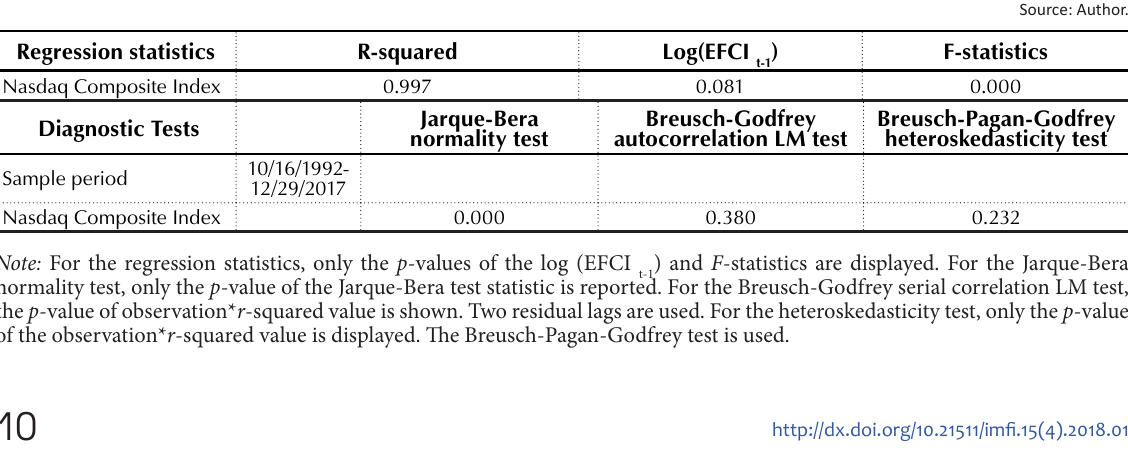
Table 5. Regression statistics and diagnostic